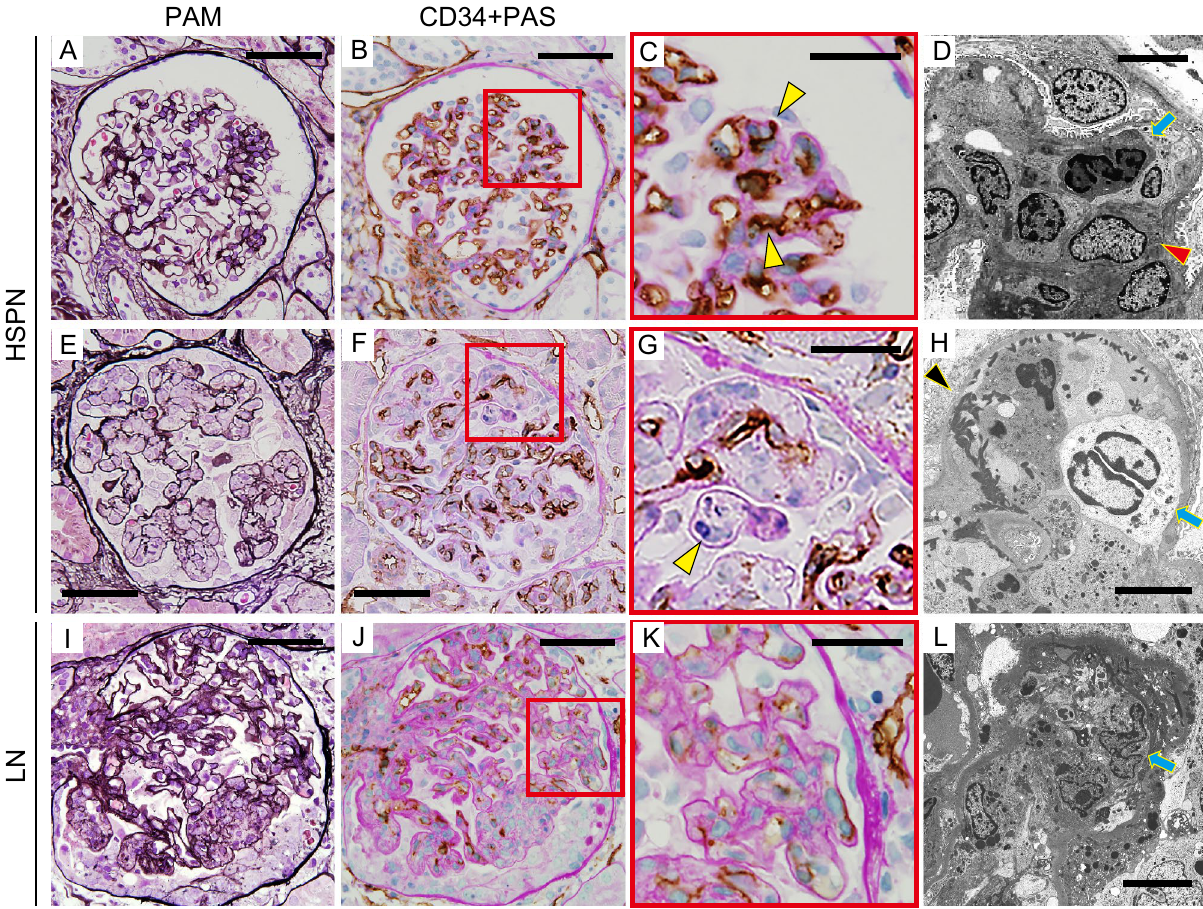
Figure 2. Severe glomerular capillary injury by endocapillary proliferation in HSPN and LN. Representative images of moderate ( A – D ) and severe ( E – H ) HSPN lesions and severe LN lesions ( I – L ). ( A , E , I ) show PAM staining; ( B , C , F , G , J , K ) show CD34 staining; and ( D , H , L ) show electron microscopy. Arrowheads (black) indicate GBM thinning ( H ). Arrowheads (red) indicate endothelial cells ( D ). Arrows indicate inflammatory cells ( D , H , L ). Scale bars, 50 μm ( A , B , E , F , I , J ); 20 μm ( C , G , K ); 5 μm ( D , H , L acid-Schiff (PAS) counterstain (Supplementary Figure 1A–C). Immunostaining for CD31 and vWF was weak and undetectable compared to CD34 staining. As we have used CD34 immunostaining to detect glomerular endothe- lial cells in healthy and diseased glomeruli, we used this method here as well 8,12,13 . Glomerular capillary loops were circular and well dilated, which implied normal glomerular blood flow in patients with MGAs (Fig. 1B,C). Electron microscopy (EM) images showed endothelial cells with maintained fenestra (Fig. 1D). Conversely, in patients with PSAGN with mild endocapillary proliferation (Fig. 1E), the number of small capillary loops defined by CD34-positive endothelial cells increased, and they were relocalized to the periphery of the glomerular tufts (Fig. 1F,G). Interestingly, these capillaries were not collapsed. By EM, we observed endothelial cell swelling and disappearance of the fenestra, as well as inflammatory cell infiltration into the glomerular capillaries (Fig. 1H), indicating glomerular endothelial cell injury. In severe EP lesions, CD34-positive areas displayed dots or short curved lines, indicating collapsed capillaries (Fig. 1I,J). High-magnification images revealed that CD34-positive endothelial cells were separated from the GBM, suggesting a widening of the subendothelial spaces (Fig. 1K). EM images clearly showed the migration of inflammatory cells into the subendothelial spaces and the swelling of endothelial cells (Fig. 1L). However, the GBM structure was maintained, and fibrin exudation was rarely observed. Endocapillary proliferation results in severe glomerular capillary injury in HSPN and LN. We next assessed changes in the glomerular capillary network by PAM staining and CD34 immunostaining of sam- ples from patients with HSPN and LN with EP lesions. In patients with HSPN with mild segmental EP lesions (Fig. 2A), CD34-positive glomerular capillary loops were narrowed and occasionally separated from the GBM (Fig. 2B,C, arrowheads), unlike in PSAGN. EM images showed endothelial cell swelling and loss of fenestra, and migration of inflammatory cells into the subendothelial space despite only mild proliferation (Fig. 2D). In moderate and severe global proliferative lesions (Fig. 2E), CD34-positive areas presented dots or curved lines, and some disappeared (Fig. 2F,G, arrowhead). EM revealed infiltration by numerous inflammatory cells, the disappearance of endothelial cells with massive fibrin exudation, and thinning of the GBM (Fig. 2H).